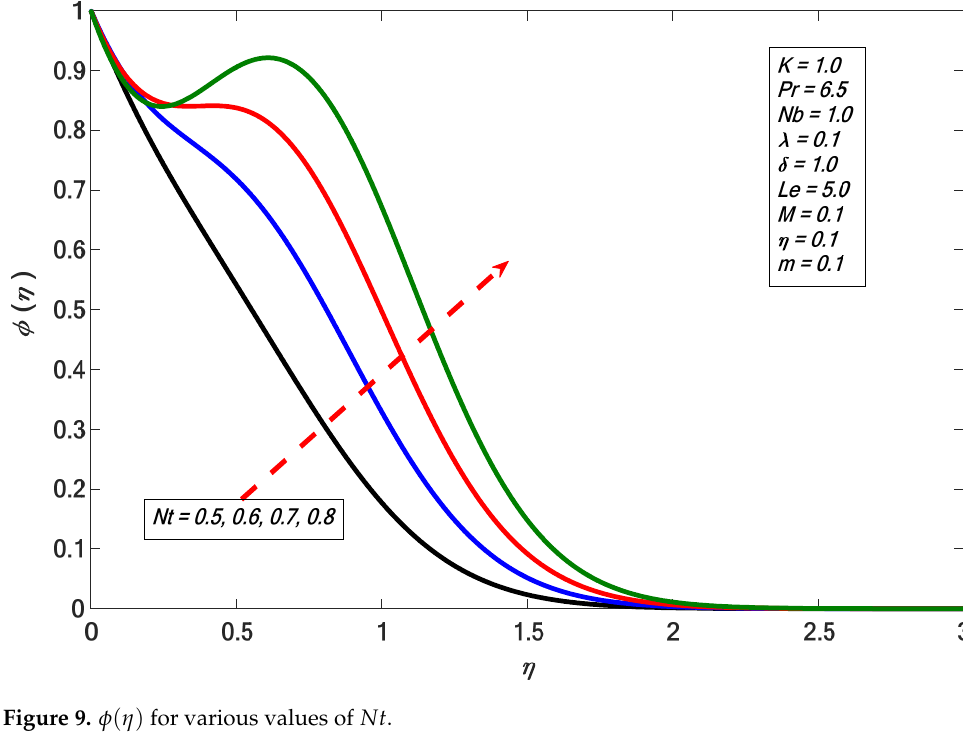
Figure 9. 𝜙(cid:4666)𝜂(cid:4667) for various values of 𝑁𝑡 . Figure 9. φ ( η ) for various values of Nt .